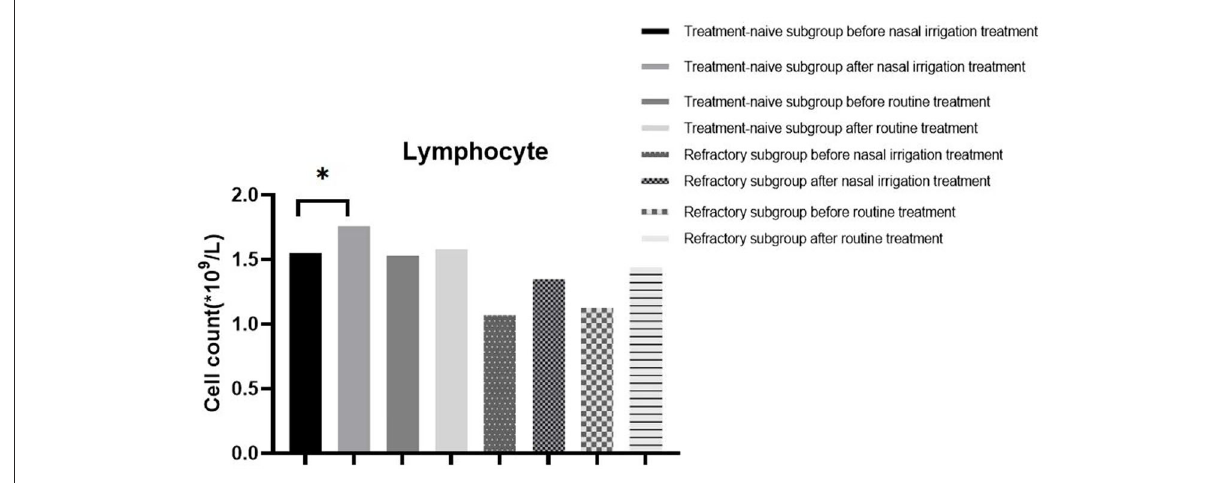
FIGURE3 LYM count in the subgroup before and after different treatments. * P <